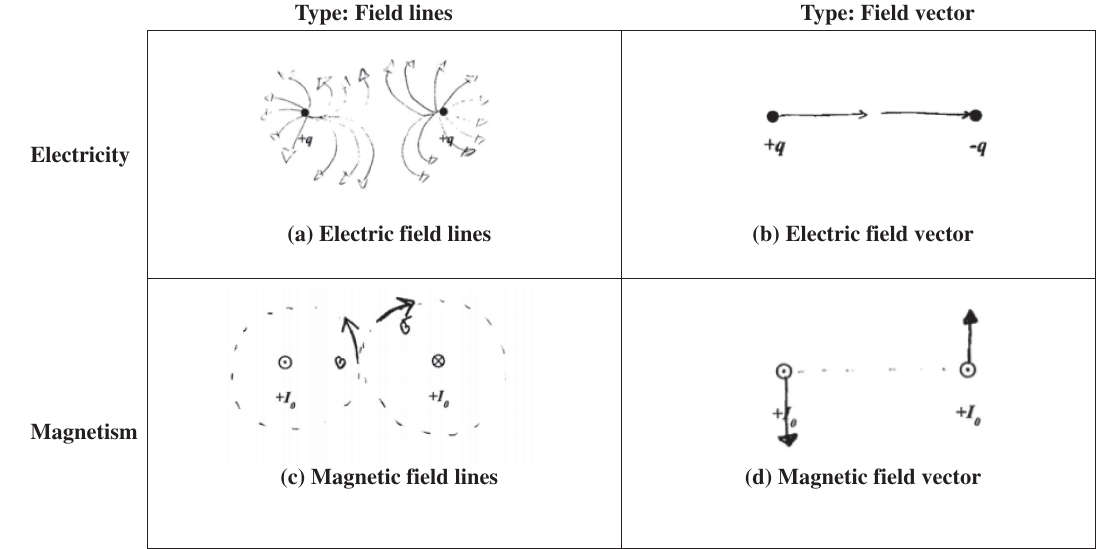
FIG. 9. Student examples of visual representations for the force-field confusion category for items 1 and 2 in each